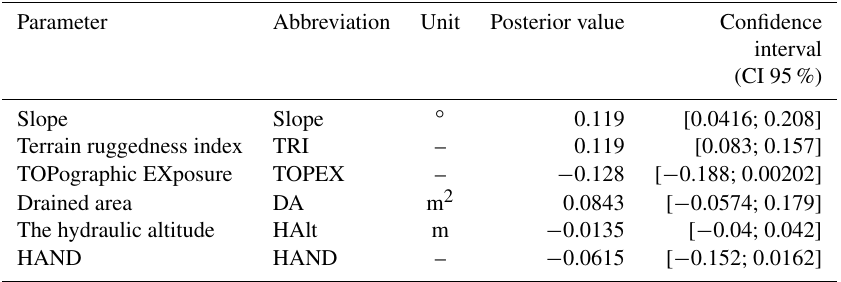
Table A1. List of environmental variables, abbreviations, units, and values of the posteriors in univariate models for a height threshold equal to the 0.0001th percentile of the height distribution of the canopy.